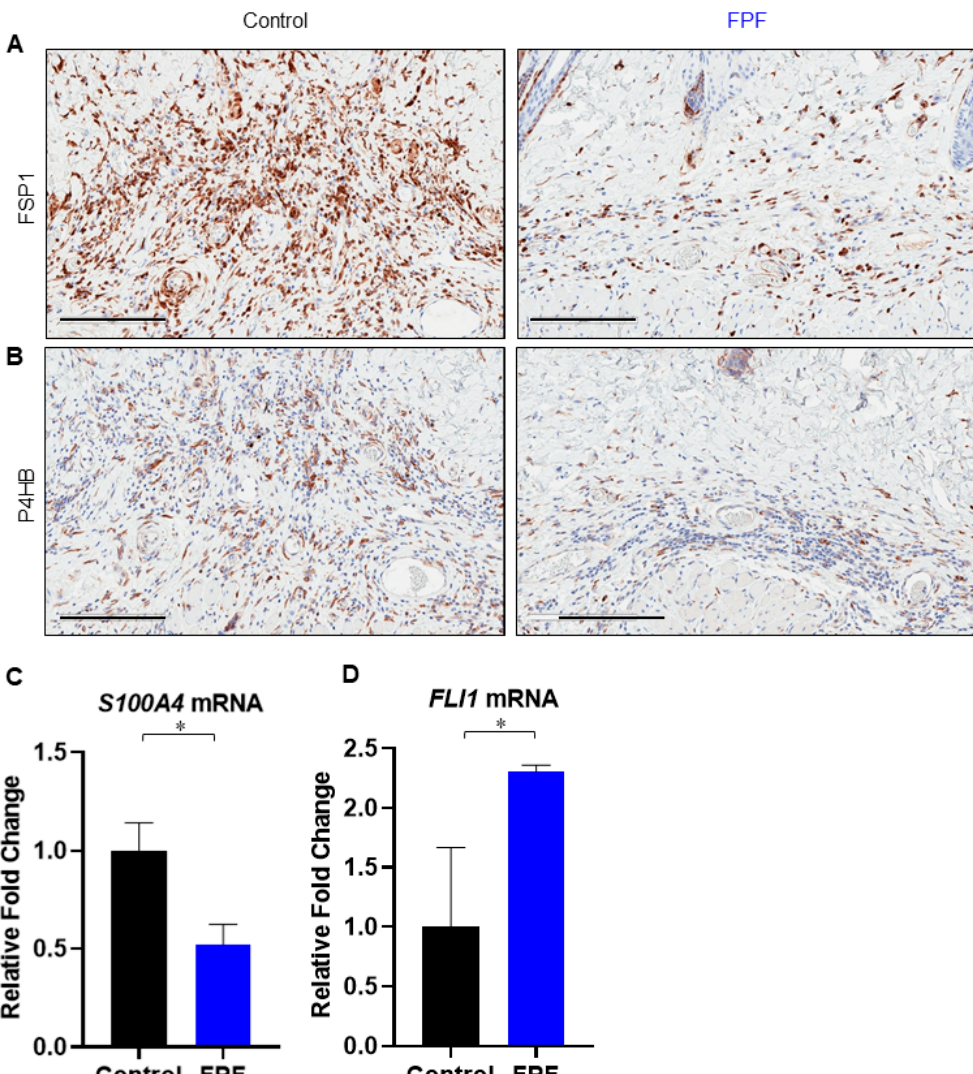
Figure 6. FPF treatment reduces the number of fibroblasts and the endothelial to mesenchymal transition. Para ffi n sections from control ( left panel ) and FPF-treated ( right panel ) mice were stained with antibodies to FSP1 to detect fibroblasts ( A ) and P4HB to show cells undergoing endothelial to mesenchymal transition ( B ). The lower number of both FSP1-and P4HB-positive cells in FPF-treated mice compared to control mice was consistent with a decrease in infiltrating cells undergoing endothelial to mesenchymal transition following FPF treatment. Representative images of five animals per group are shown. Scale bars = 200 µ m. RT 2 qPCR for ( C ) S100A4 and ( D ) FLI1 in control (black bars) and FPF (blue bars)-treated mice. N = 3 mice / group. * p <